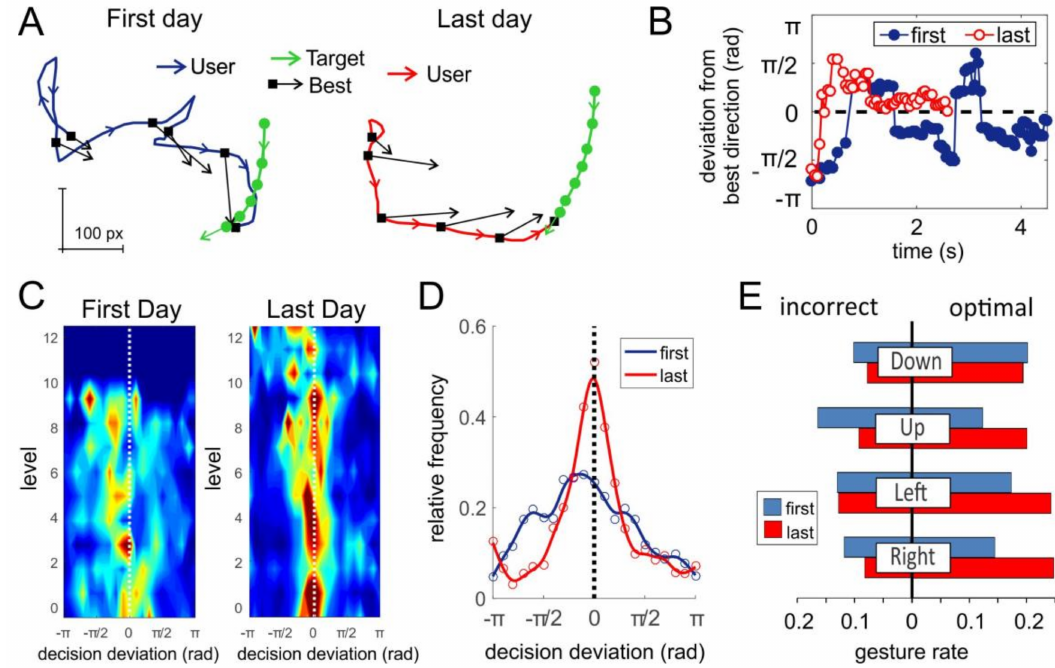
Figure 8. Analysis of the gaming performance of a single subject playing the pacman game at the first day and after ten-days training. ( A ) Representative example of two game trials (in the first day and after training). Green arrowed curves show the movement of the target. Blue and red curves correspond to the trajectory of pacman. Black arrows mark the best game decisions along trajectories. ( B ) Deviation of the user choice from the best gaming decision along the trajectories shown in ( A ). ( C ) Histograms of the decision deviation from best direction along game levels (color from blue to red represents the frequency of the corresponding deviation). ( D ) Relative frequency (probability) of the trajectory deviation from the optimal direction. ( E ) Rates of incorrect and optimal gestures used for controlling pacman before and after